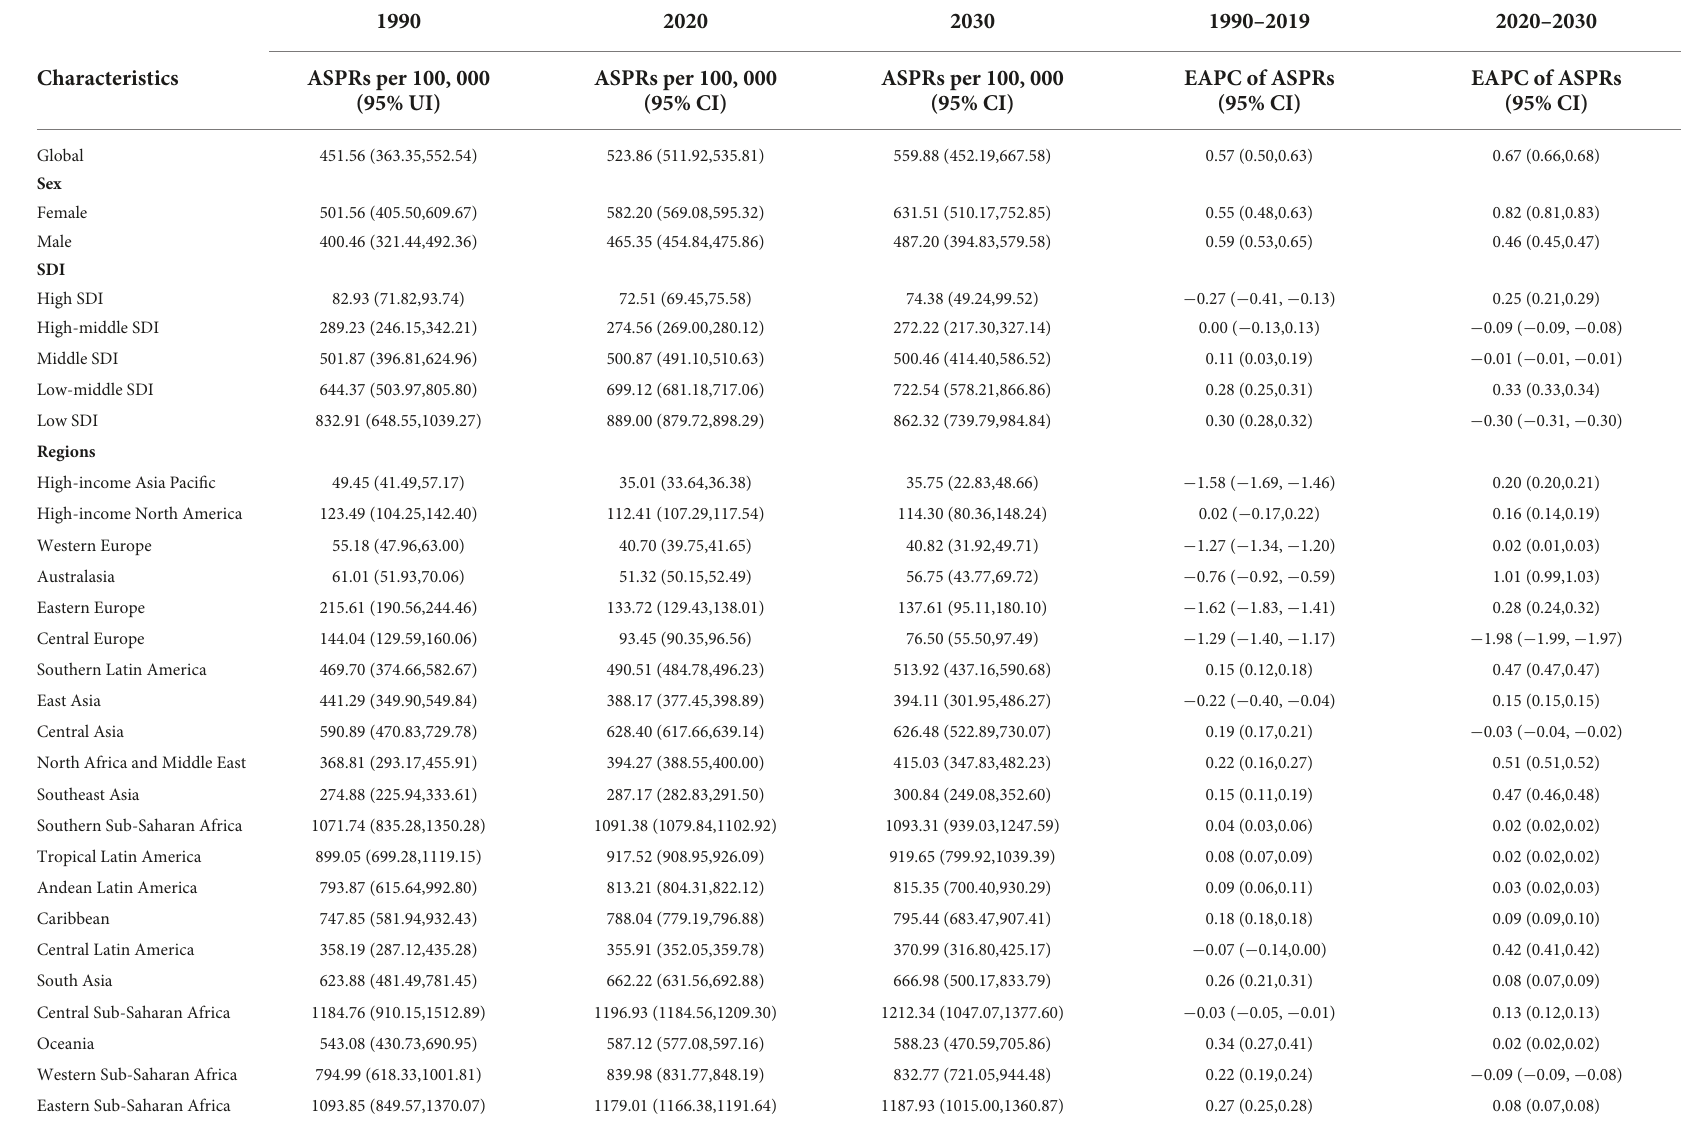
TABLE 1 The RHD-related ASPRs in 1990, 2020, and 2030, and their temporal trends from 1990 to 2019 and from 2020 to